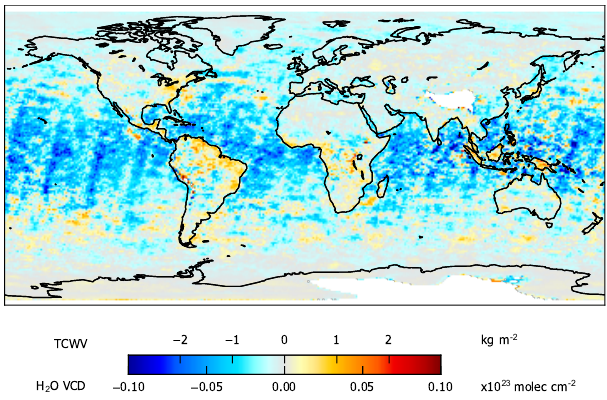
Figure 5. Mean difference of GOME-2 and SCIAMACHY TCWV during the overlap period January 2007 to March 2012, calculated as the mean of monthly means.